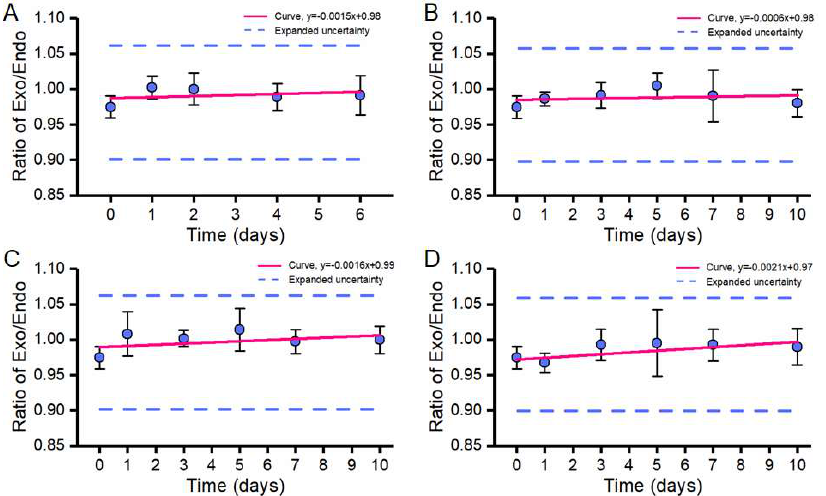
Figure 2. Long-term stability of the candidate CRM at −20 °C ( A ), and short-term stability at 4 ( B ), 25 ( C ), and 60 °C ( D ). The solid line represents the linear regression curve, whereas the dashed lines indicate the range of the standard uncertainty.